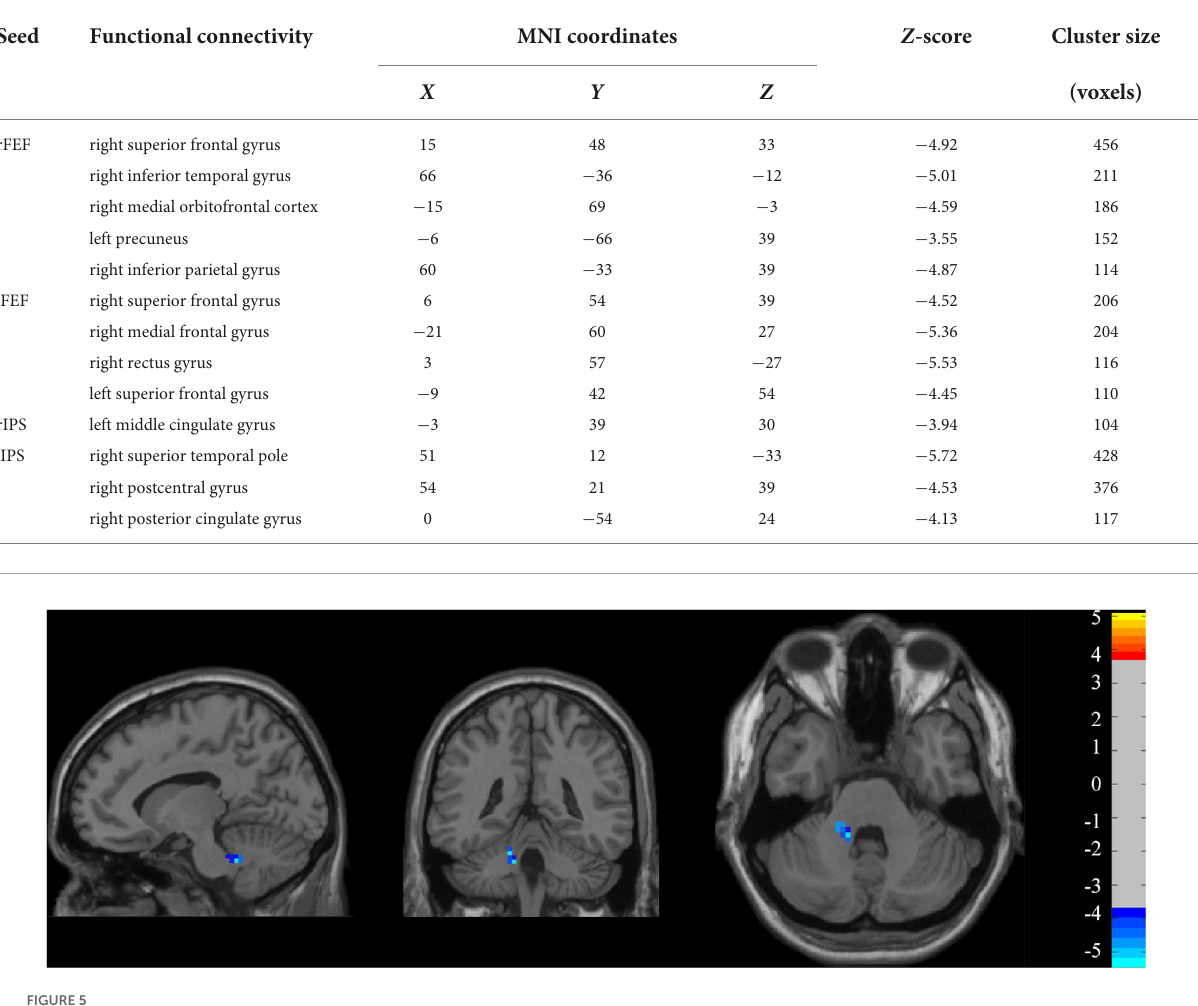
TABLE 2 Group differences in functional connectivity of DAN and VAN ROIs.